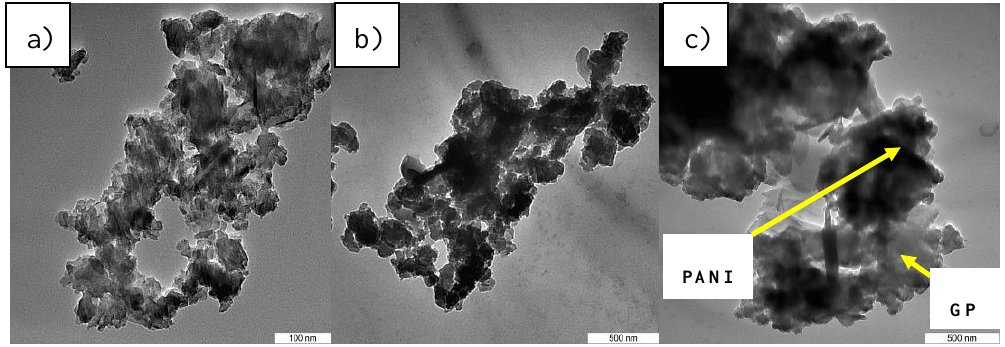
Figure 4. TEM images of ( a ) PANI nanofibers 3 wt % of PMVEA; ( b ) graphene and ( c ) PANI/GP 50 wt %.